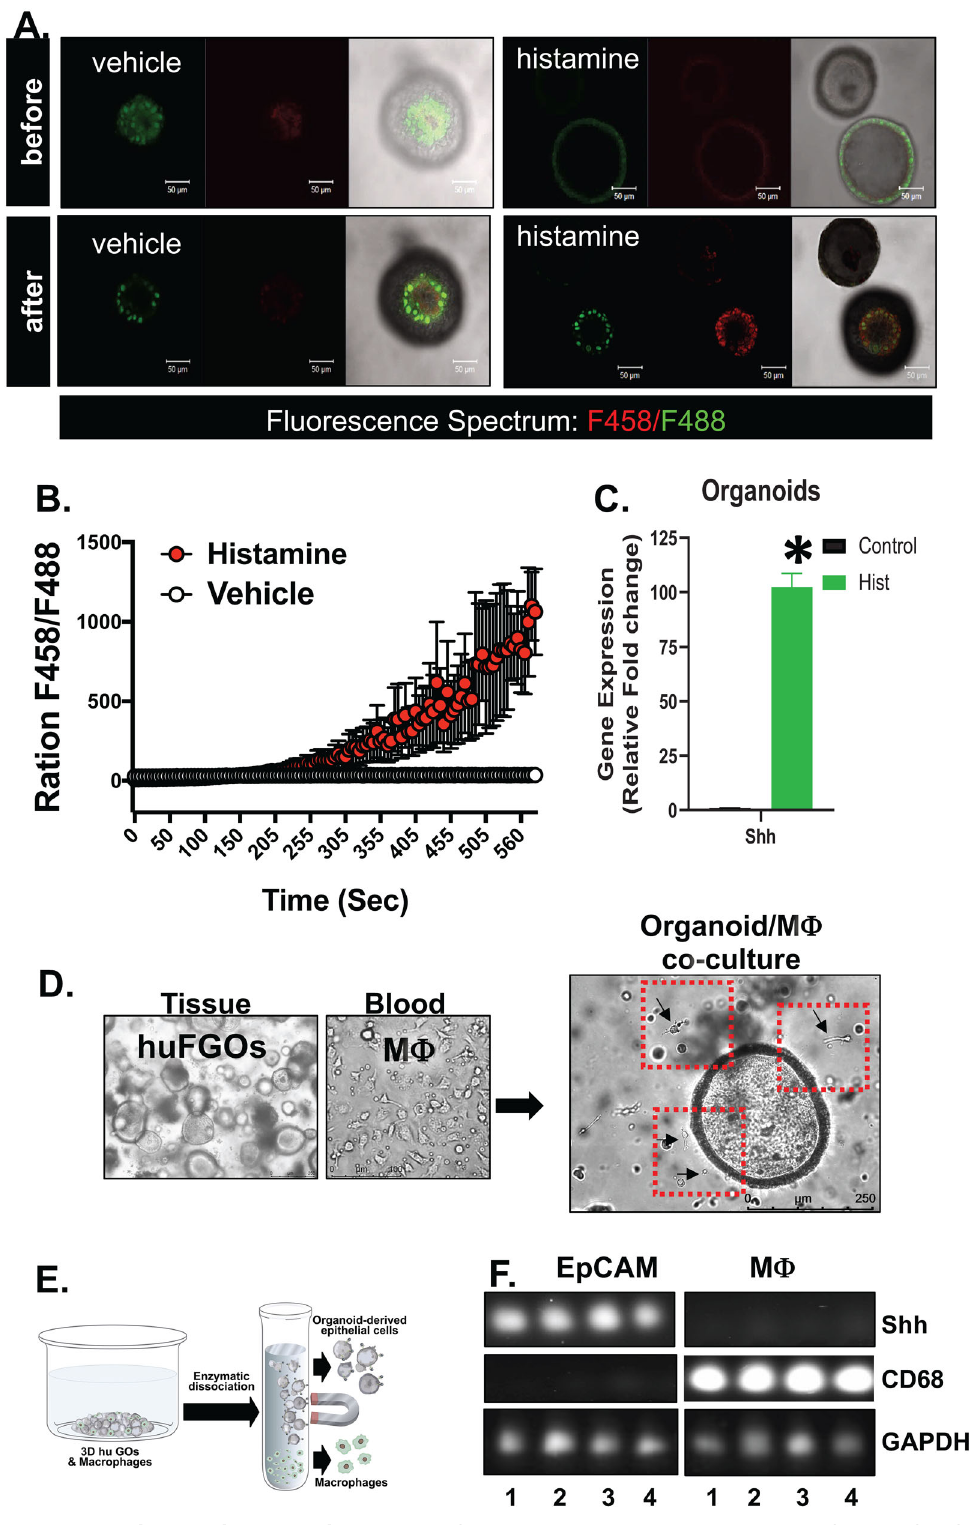
Fig. 6 Human gastric organoid/macrophage co-cultures. A Acridine orange assay using gastric organoids treated with either vehicle or histamine. B Shift in F458 (red)/F488 (green) fl uorescence ratio was measured in the organoid cultures treated with vehicle or histamine. C Quantitative RT-PCR measuring changes in Shh expression in the gastric organoids treated with vehicle (control) or histamine (Hist). * P < 0.05 compared to control, n = 4 cultures generated from four individual patients. D Bright- fi eld micrographs showing tissue-derived human fundic gastric organoids (huFGOs), PBMC-derived macrophages, and representative co-culture. E Magnetic separation was used to isolate epithelial and immune cells from treated human gastric organoid/macrophage co-cultures. F RT-PCR demonstrating expression of Shh in EpCAM positive and CD68 in macrophage fractions. Data are shown as the mean ±